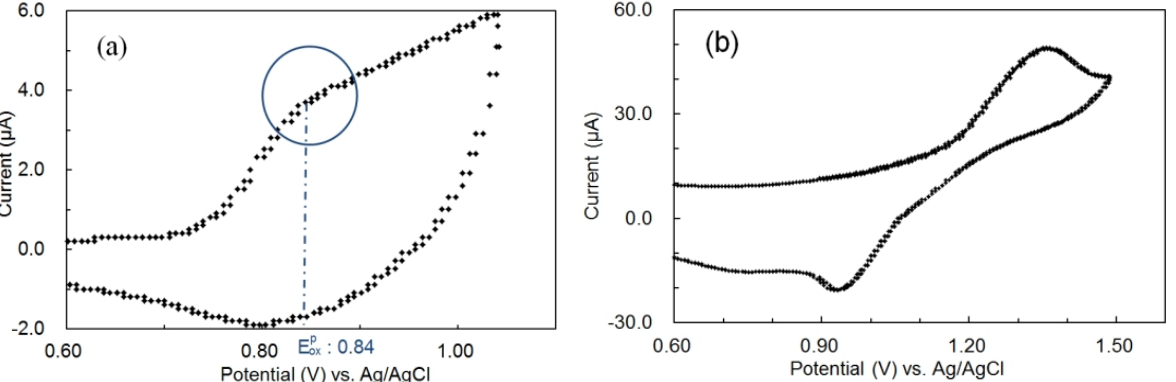
Figure 5. Cyclic voltammograms of ( a ) 3.5 × 10 − 2 wt % P3OT in 1,2-dichlorobenzene (DCB) containing 0.1 M tetra-butyl ammonium perchlorate (TBA) and ( b ) 1.0 × 10 − 2 M perylene in DCB containing 0.1 M TBA at a sweep rate of 20 mV/s (Working electrode: gold; Counter electrode: platinum; Reference electrode: Ag/AgCl).